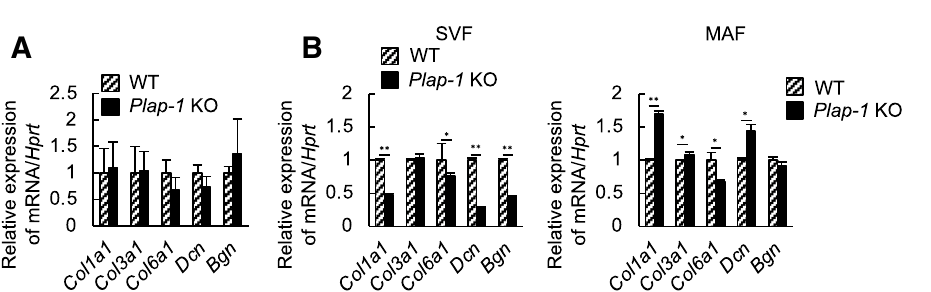
Figure 7. ECM gene expressions in adipose tissue. ( A ) ECM gene expressions in subcutaneous adipose tissue of WT and Plap-1 KO mice were investigated by real-time PCR analysis. ( B ) ECM gene expressions in SVF and MAF isolated from WT and Plap-1 KO mice were investigated by real-time PCR analysis. All data are represented as relative expression to WT. Col1a1: collagen, type I, alpha 1, Col3a1: collagen, type III, alpha 1, Col6a1: collagen, type VI, alpha 1, Dcn: Decorin, Bgn: Biglycan. Results show the mean ± SD of triplicate assays. n = 3, *: p < 0.05, **: p <